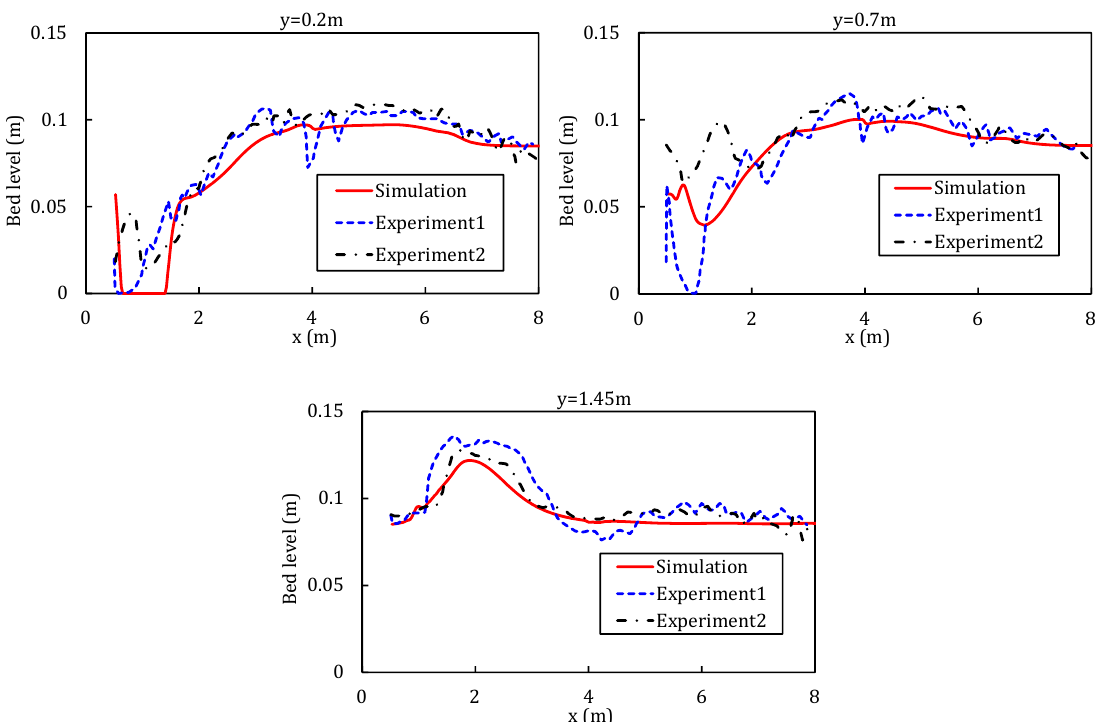
Figure 16. The measured and calculated bed profiles along three longitudinal